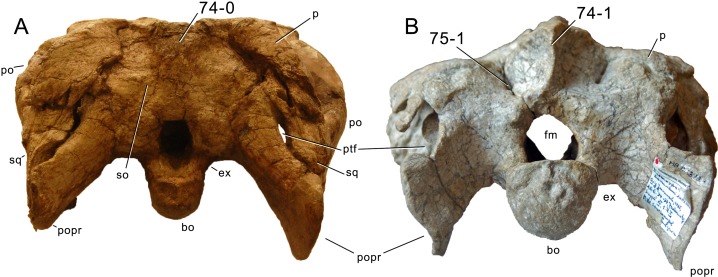
Flagellicaudatan skulls in posterior view.Skulls of Diplodocus sp. CM 11161 (A) and Dicraeosaurus hansemanni MB.R.2379 (B) in posterior view, illustrating the development of the sagittal nuchal crest (C74), and the supraoccipital foramina (C75). Abb.: bo, basioccipital; ex, exoccipital; fm, foramen magnum; p, parietal; po, postorbital; popr, paroccipital process; ptf, posttemporal fenestra; so, supraoccipital; sq, squamosal. Skulls scaled to the same skull width.